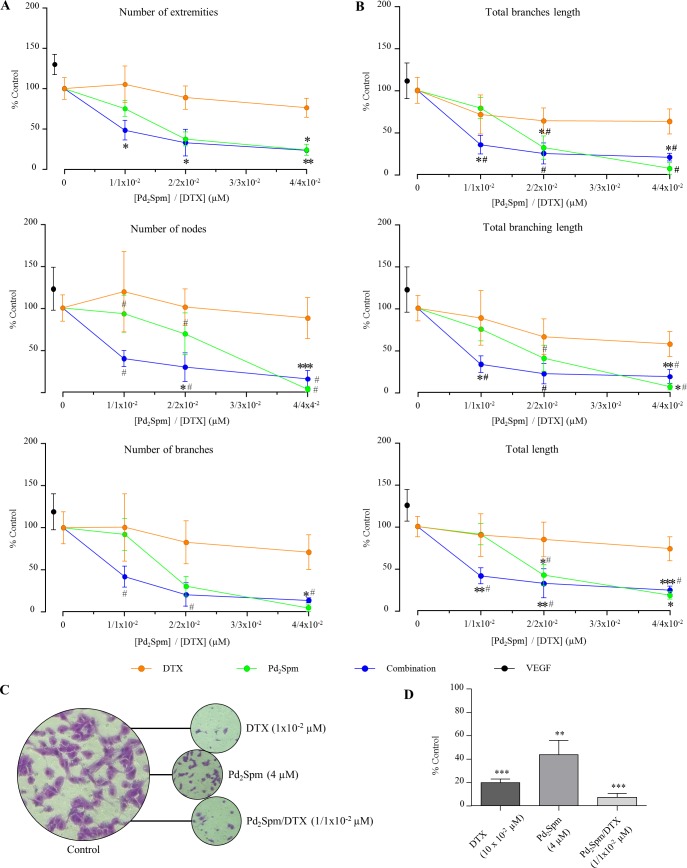
Anti-invasive assays in the presence of DTX, Pd2Spm and DTX with Pd2Spm combination.Quantitative CAM angiogenesis results in the presence of increasing concentrations of DTX, Pd2Spm and Pd2Spm/DTX. Eight days after fertilization, DTX, Pd2Spm, VEGF (positive control) or PBS (negative control) were added to the coverslip (previously sterilised and treated with hydrocortisone). After incubating the eggs for 48 hours, the CAMs were peeled off and photographed. Digital images were analysed using the Angiogenesis Analyser for Fiji [25]. (A)–number of extremities, nodes and branches; (B)–total branches length, total branching length, total length. Anti-migratory assays for the MDA-MB-231 cell line upon exposure to DTX, Pd2Spm and Pd2Spm/DTX combination, MDA-MB-231 cell invasion on MatrigelTM: (C)–Microscopic image (x10) of MDA-MB-231 cells treated with DTX (1x10-2 μM), Pd2Spm (4 μM) and Pd2Spm/DTX combination (1/1x10-2 μM) stained with crystal violet or (D) quantified by simple counting. The results are expressed as a percentage of the control ± SEM. The one-way ANOVA statistical analysis was used, and the Dunnett’s post-test was carried out to verify the significance of the obtained results (*p<0.05, **p<0.01, ***p<0.001 versus the control and #p<0.05 versus the VEGF).